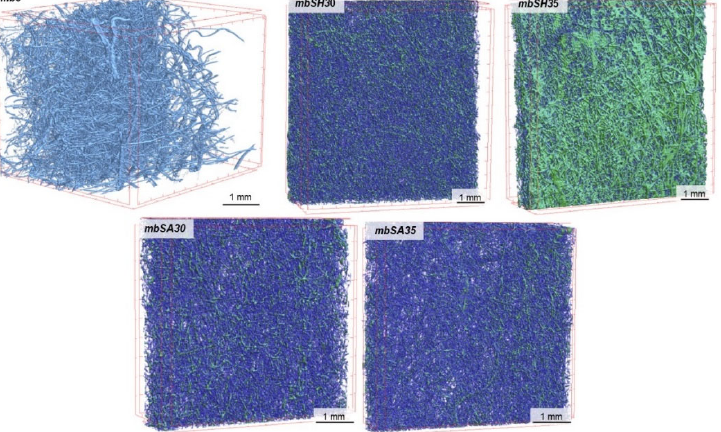
Materials 2022 , 15 , 7097 Figure 5. Micro ‐ CT images of unmodified and modified melt ‐ blown PLA nonwoven fabrics. Figure 5. Micro-CT images of unmodified and modified melt-blown PLA nonwoven fabrics.